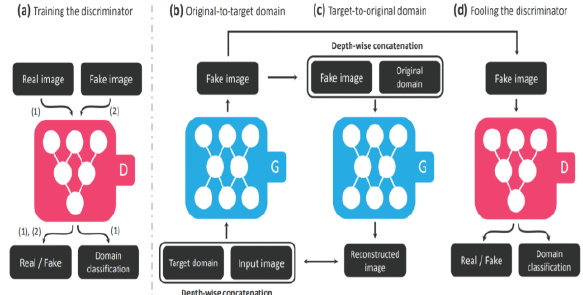
Fig. 2. GAN’s General Architecture